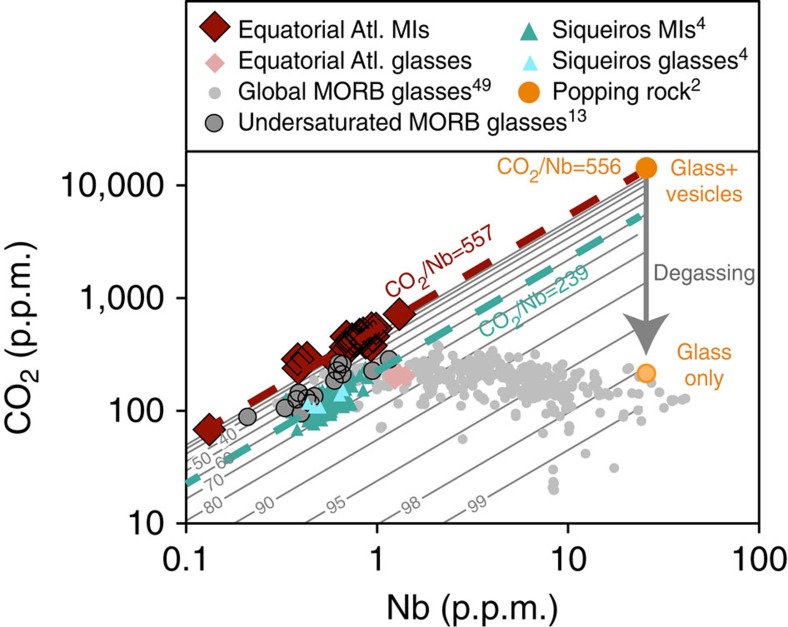
Variation in CO2 content as a function of Nb content.Red dashed line: average CO2/Nb in the equatorial MAR melt inclusions. The Siqueiros melt inclusions4 (green dashed line: average CO2/Nb) and matrix glasses4, the popping rock2 and the undersaturated ultradepleted MORB glasses13 are also plotted for comparison. The matrix glasses from both Siqueiros and equatorial MAR samples plot consistently with the global MORB glass database49, affected by variable amounts of carbon degassing (thin grey lines, graduated in % of CO2 loss, assuming an initial undegassed CO2/Nb of 557).